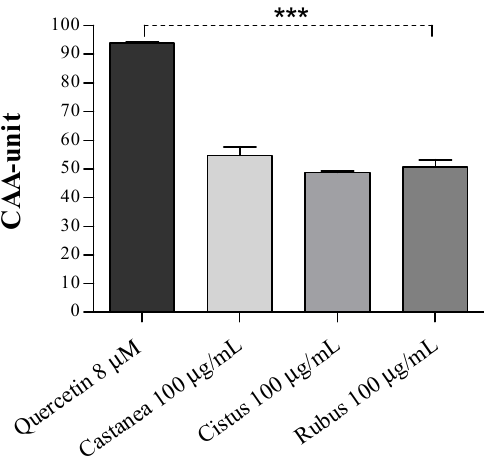
Figure 1. Effect of Castanea , Cistus, and Rubus bee pollen extracts (100 µg/mL) on the cellular antioxidant activity (CAA) of oxidized human erythrocytes. Quercetin (8 µM) was used as the reference standard. Results were expressed as mean ± SD. One-way analysis of variance (ANOVA) with Tukey’s multiple comparison test: * significantly different from control cells (AAPH-treated cells, CAA = 0), *** p <